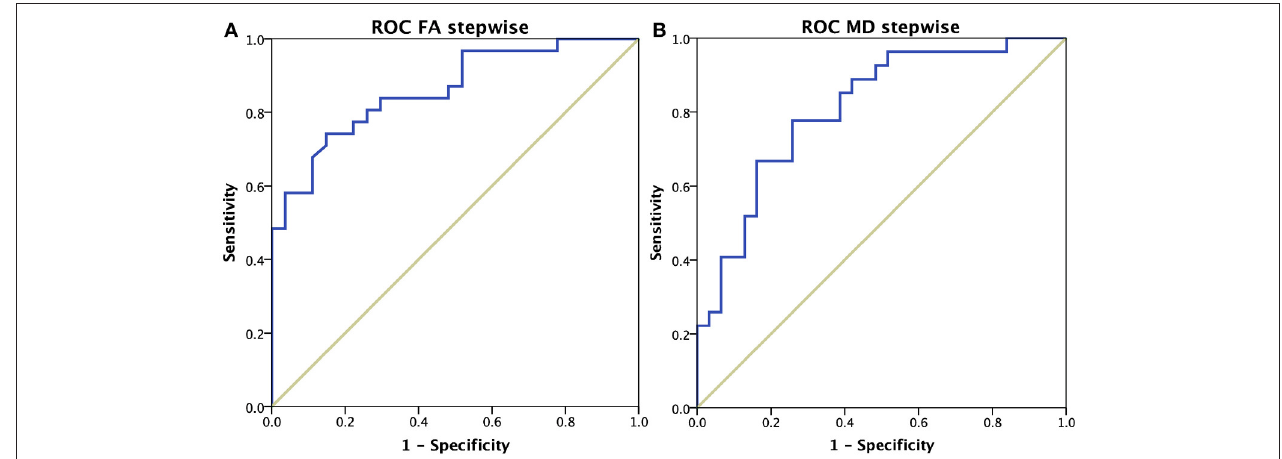
FIGURE 3 | ROC curves of dementia subgroups differentiation. (A) Results using mean FA values of five brain regions: left parahippocampal tract, right cingulum, genu of the corpus callosum, and bilateral anterior thalamic radiations. (B) Results using mean MD values of two brain regions: left parahippocampal tract and right anterior thalamic radiations.